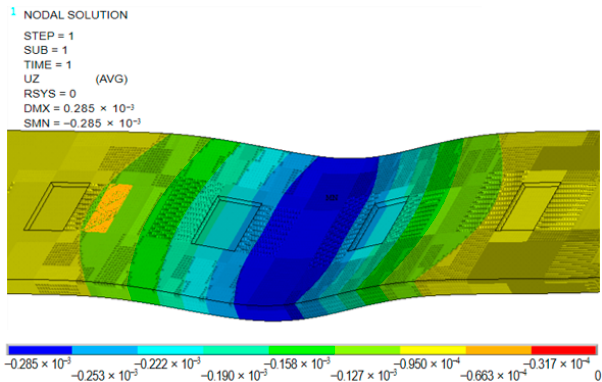
Figure 14. Deformation of the base plate.